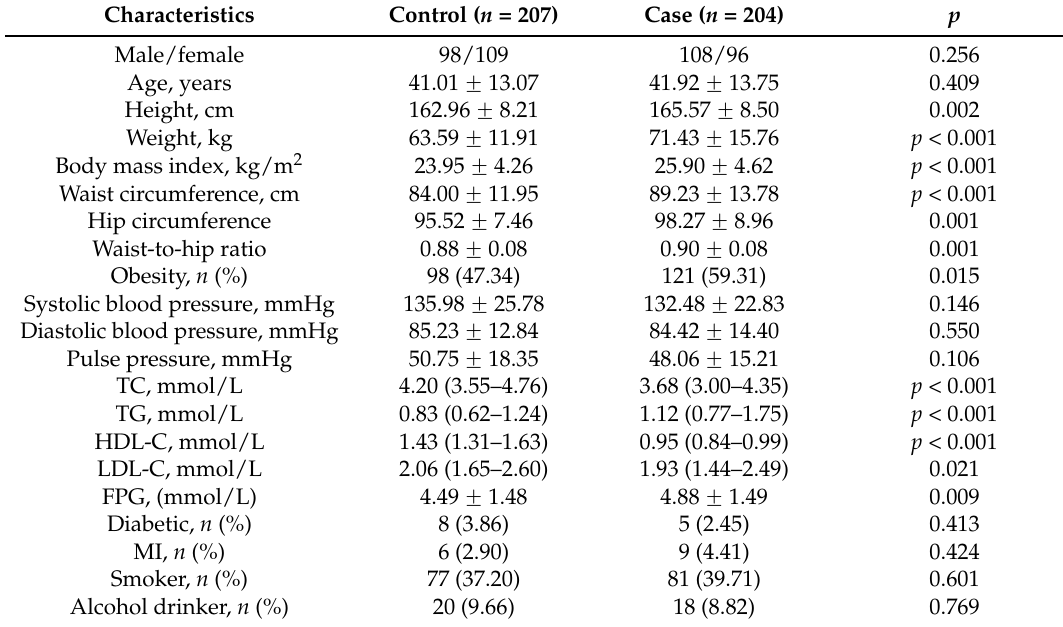
Table 2. The general characteristics and serum lipid levels between the control group and case